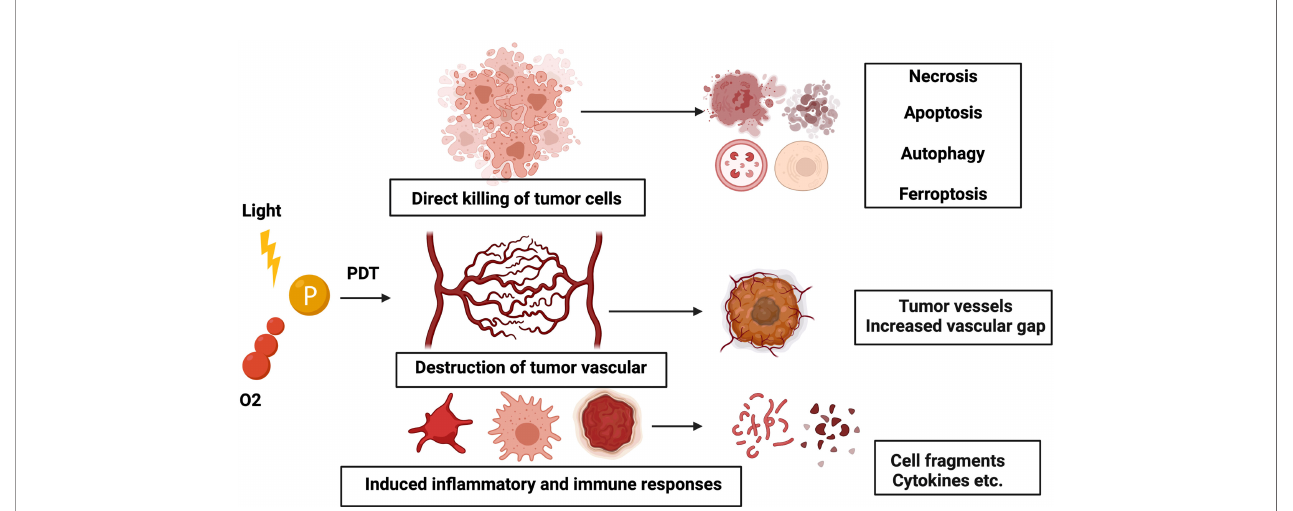
FIGURE 1 | Schematic illustration of the mechanism of PDT. Three mechanisms of PDT-mediated tumor injury in vivo : (1) direct killing of tumor cells, (2) damage to the vasculature, and (3) in fl ammation and immune